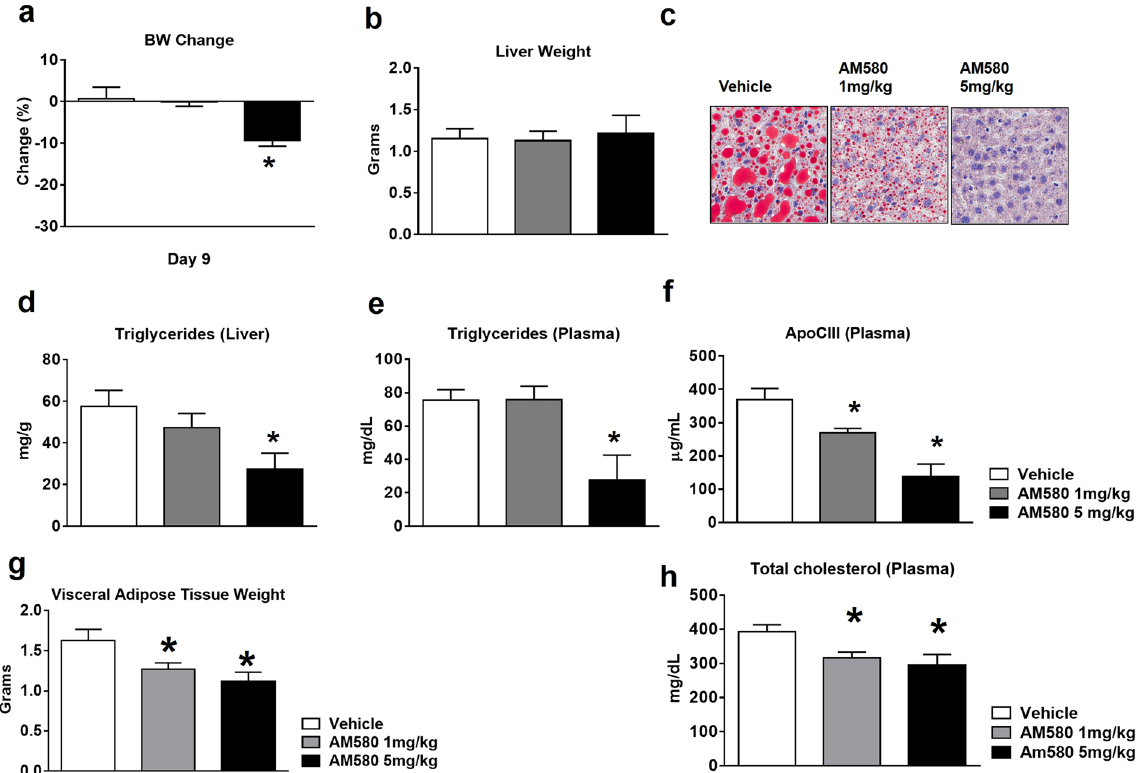
Figure 4. Effect of RAR α agonist on ApoC-III and TGs production in high fat diet induced fatty liver mice. 4-month-old HFD mice treated daily with AM580 at 1 and 5 mg/kg by oral gavage. After 9 days, mice were sacrificed for plasma and tissue level analysis of ApoC-III and TGs and TCs. ( a ) Percentage body weight change; ( b ) Liver weight; ( c ) Hepatic lipids were stained by oil red O staining; ( d ) TGs levels in liver lysate and ( e ) Plasma TGs levels. ( f ) Plasma ApoC-III levels were measured by ELISA assay; ( g ) Visceral adipose tissue weights and ( h ) Plasma total cholesterol levels were measured by biochemical assay after 9 days of AM580 treatment in DIO mice. Data are means ± S.E. of 5–8 animals per group. * P < 0.05 versus